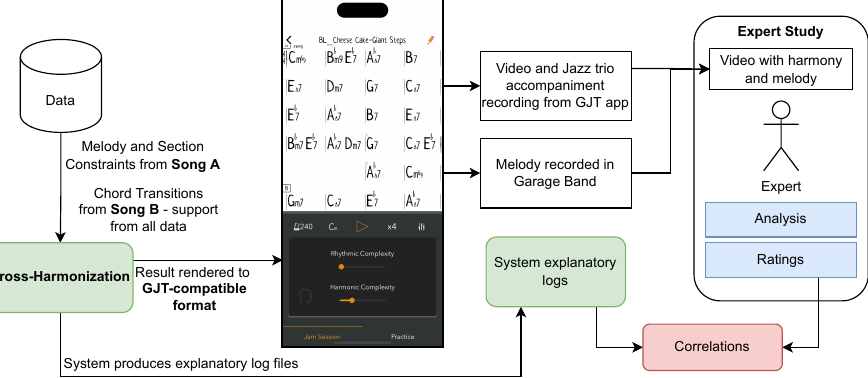
Figure 2. Experimental process pipeline. Pairs of jazz standards are selected and the system employs the presented methods to generate cross-harmonizations between them, along with the respective ex- planatory log files. The cross-harmonization output is imported to GJT and rendered to video/audio format (one repetition) in jazz trio format (drums, bass and piano). The melody, generated in Garage Band, is imported to the video and the final outcome becomes available to a jazz expert. The expert analyzes the output in free text and the most important comments are gathered. They also rate each harmonization and the correlation is examined between those ratings and several aspects of the generated harmonizations from the log files produced by the